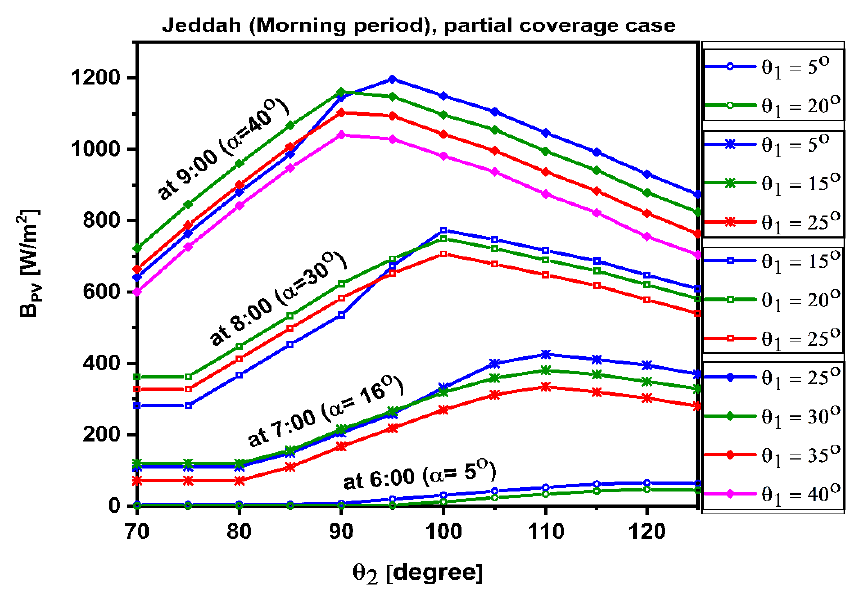
Figure 7. The irradiance B PV at fixed θ 1 angles and variable θ 2 angles for partial coverage for the solar time from sunrise to 10:00 in Jeddah.